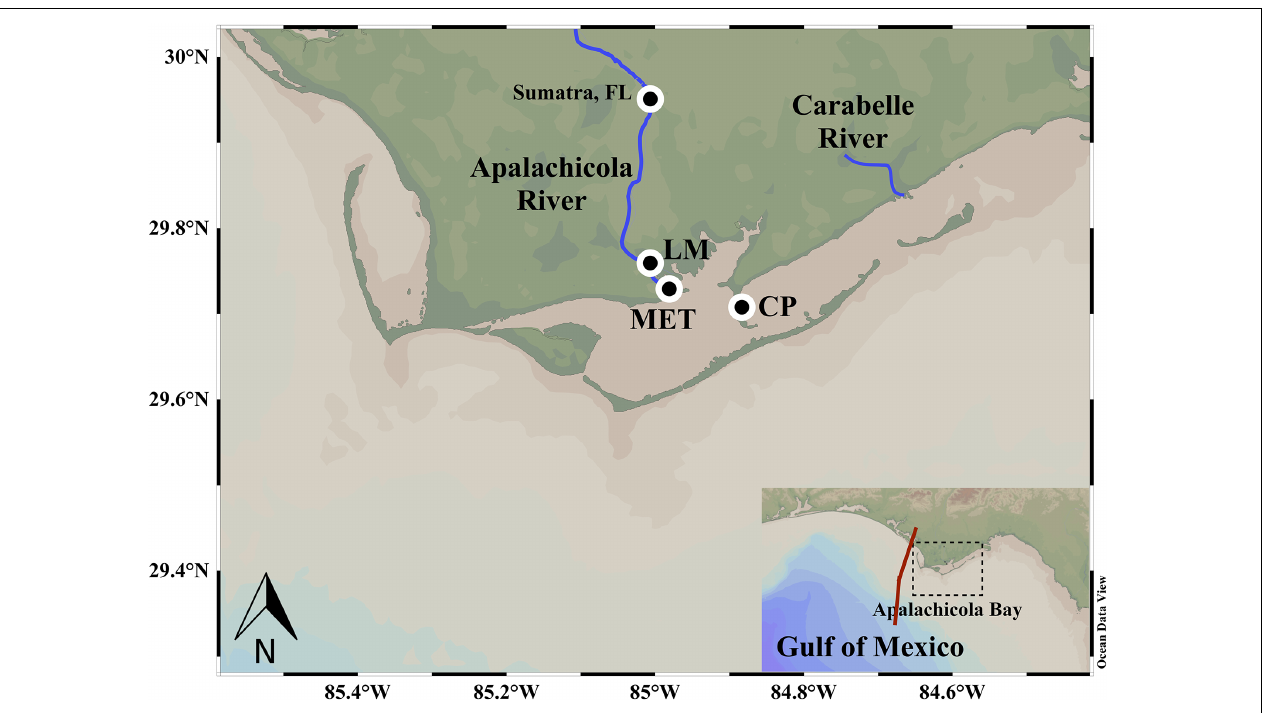
FIGURE 1 | Study area. Apalachicola Bay (ApB) and the surrounding shelf waters with the main Apalachicola River and the smaller Carabelle River flowing into the bay. Circles denote the location of the river stage station (Sumatra, FL, United States), meteorological station (LM) and the water quality monitoring station at Cat Point (CP) in ApB. Inset shows the northeast Gulf of Mexico region comprising ApB showing track of hurricane Michael (red